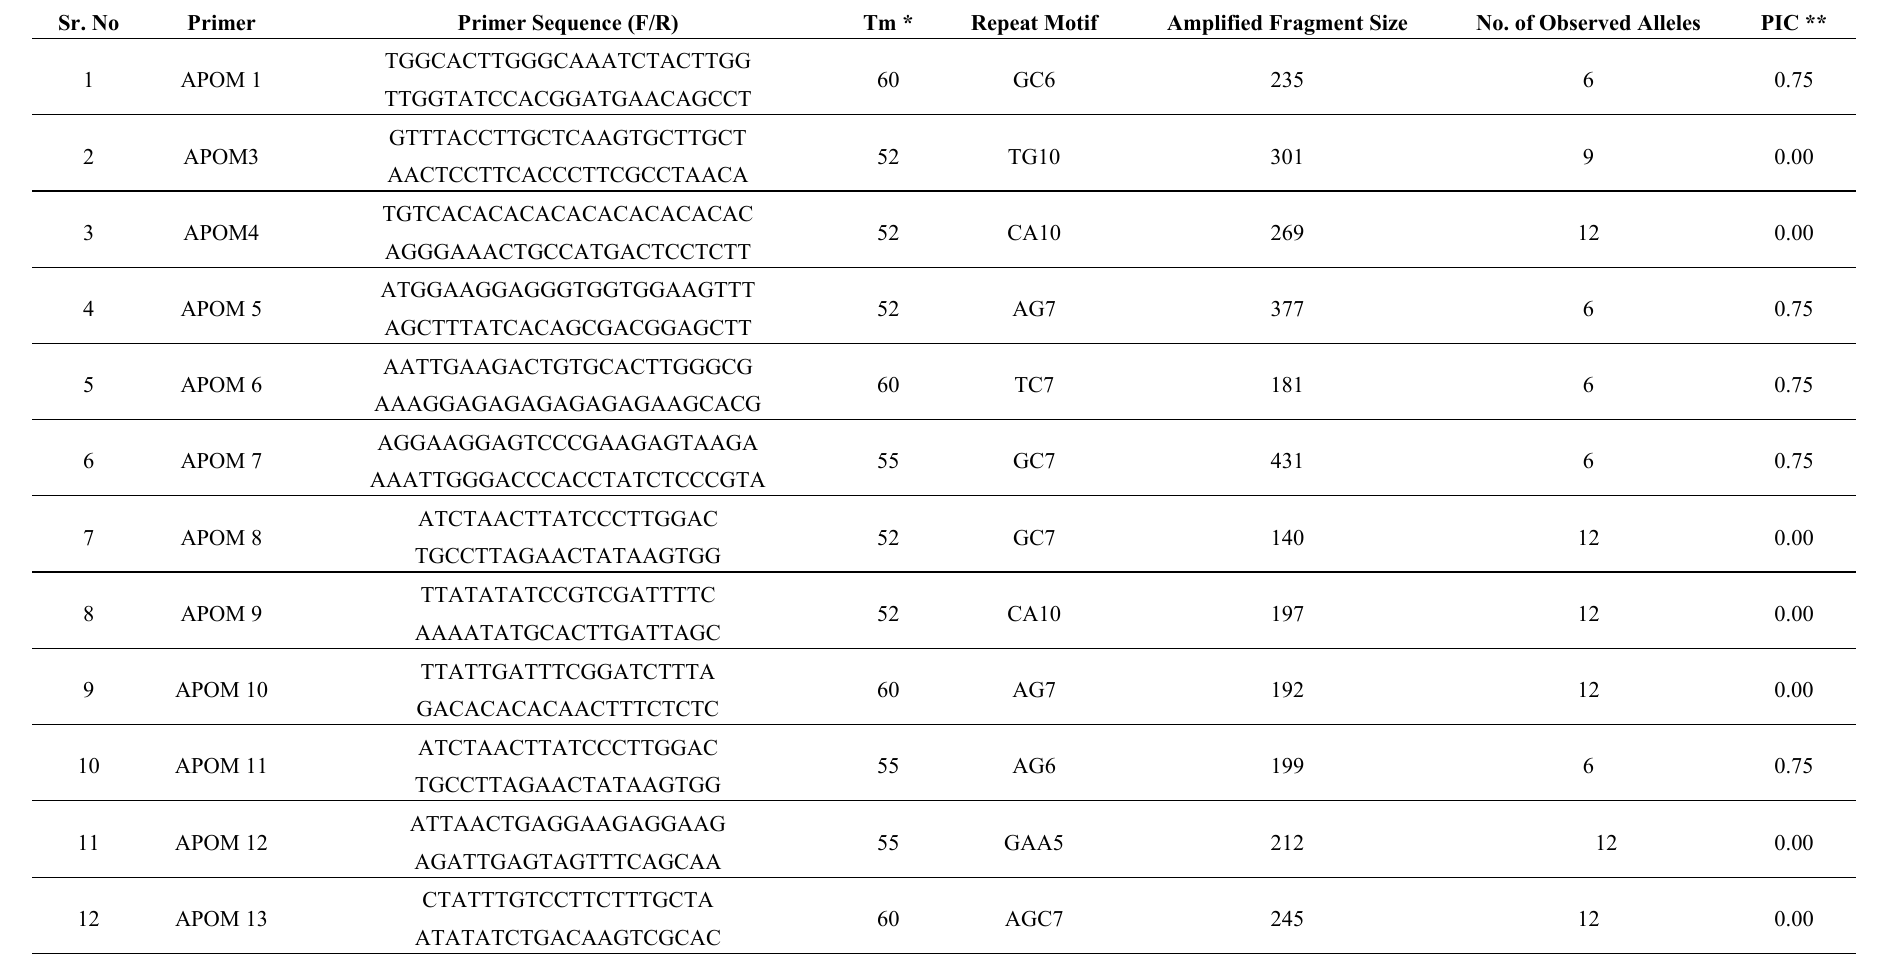
Table 4. Characteristics of the simple sequence repeat (SSR) loci isolated from P. ovata